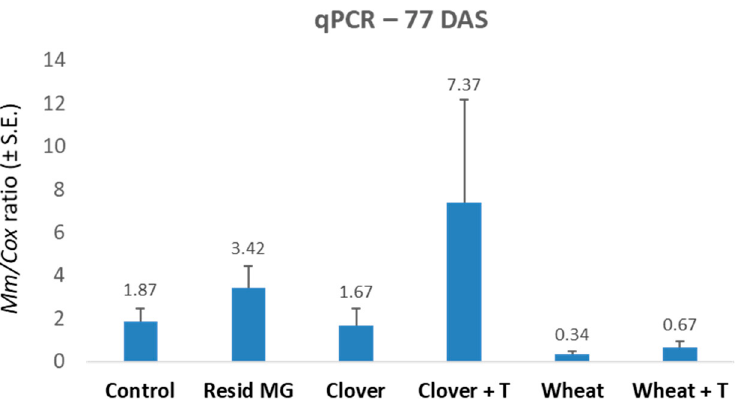
Figure 4. The 2019 soil microbiome integrity experiment—real-time PCR analysis at the experiment’s end (77 DAS). The experiment is described in Figure 1. The y -axis indicates M. maydis relative DNA ( Mm ) abundance in the roots normalized to cytochrome c oxidase ( COX ) DNA. Values indicate an average of 10 replications. Error bars indicate standard error.